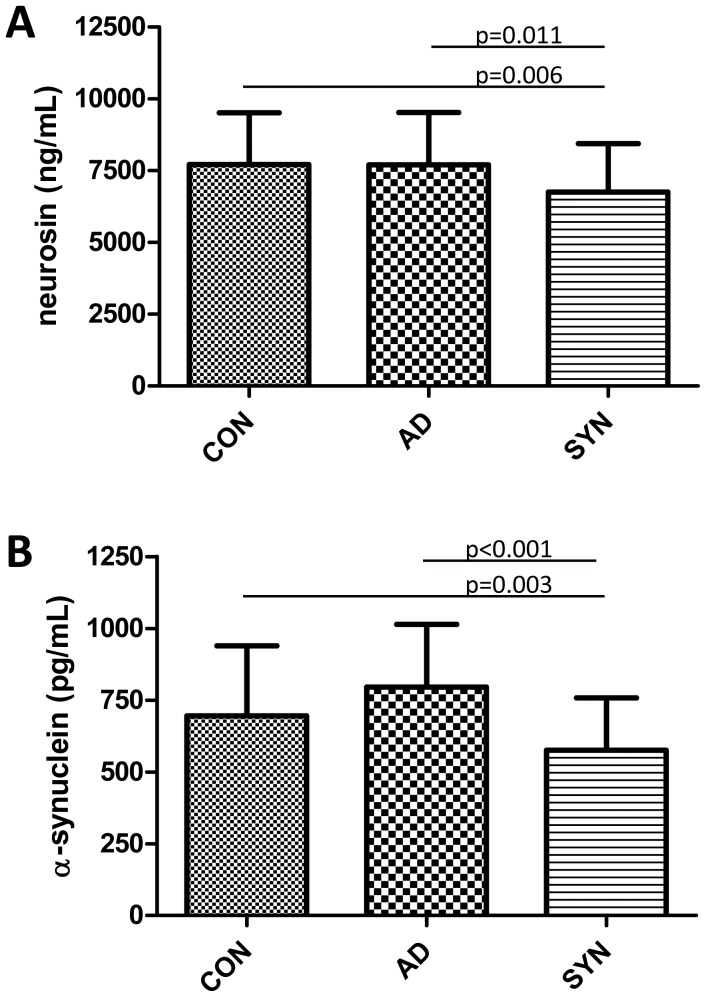
CSF levels of neurosin (A) and α-synuclein (B) in non-demented controls (CON), Alzheimer's disease patients (AD) and patients with Parkinson's disease, Parkinson's disease dementia and dementia with Lewy bodies grouped into one cumulative group of patients with synucleinopathy (SYN).Significant differences in CSF markers, as indicated by the p-values, were evaluated using ANCOVA group comparisons with correction for age or ANOVA followed by Bonferroni posthoc testing.